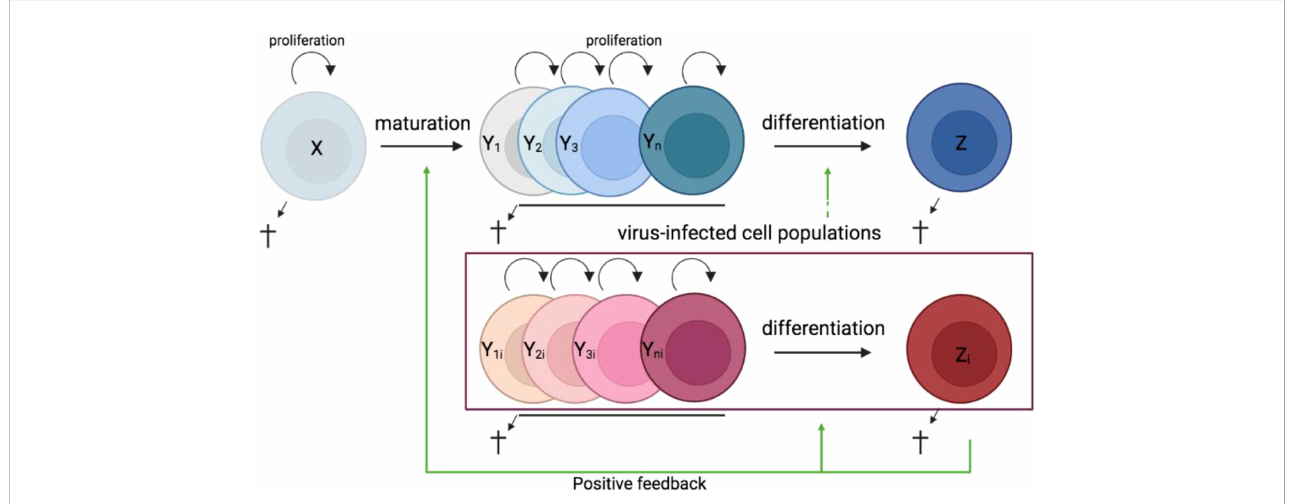
FIGURE 2 Schematic presentation of a simple feedback-controlled balance-of-growth-and-differentiation model considering lung alveolar epithelium infection with SARS-CoV-2. X, progenitor cells; Yk (k = 1, 2, … , n), AT2 cells in different maturation states; Yki, infected AT2 cells; Z, the subset of AT1 cells exerting feedback differentiation pressures; Zi, infected AT1 cells in that